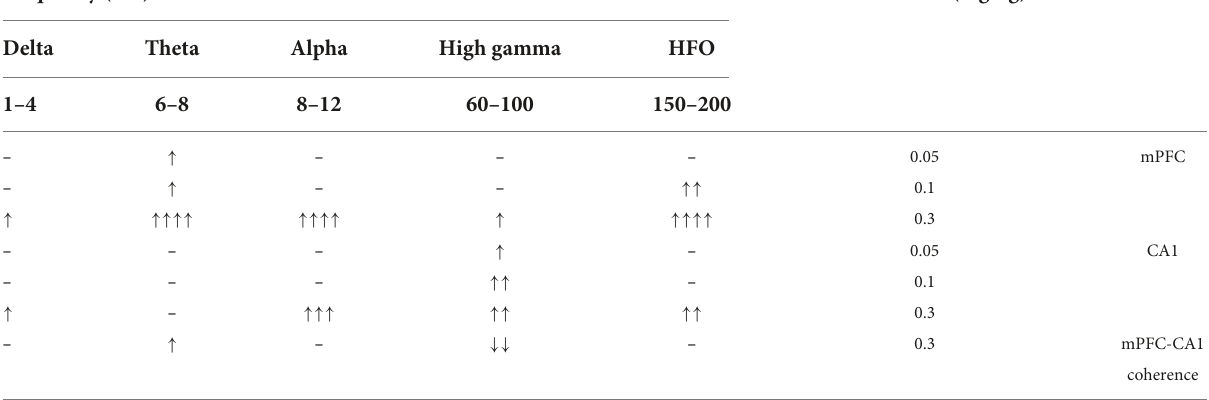
TABLE 1 Effects of MK-801 on the delta, theta, alpha, gamma, and high frequency oscillation (HFO) recorded in the prefrontal cortex and